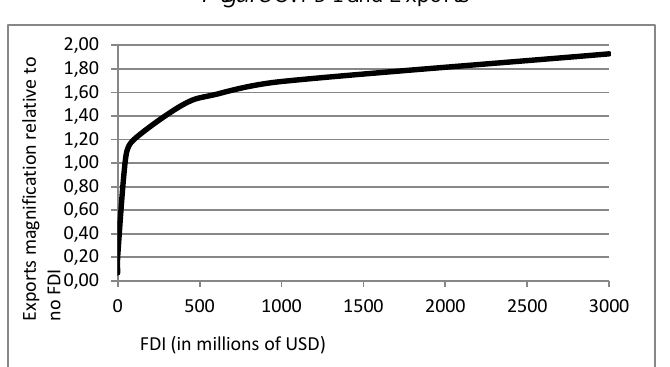
Figure 5 . FDI and